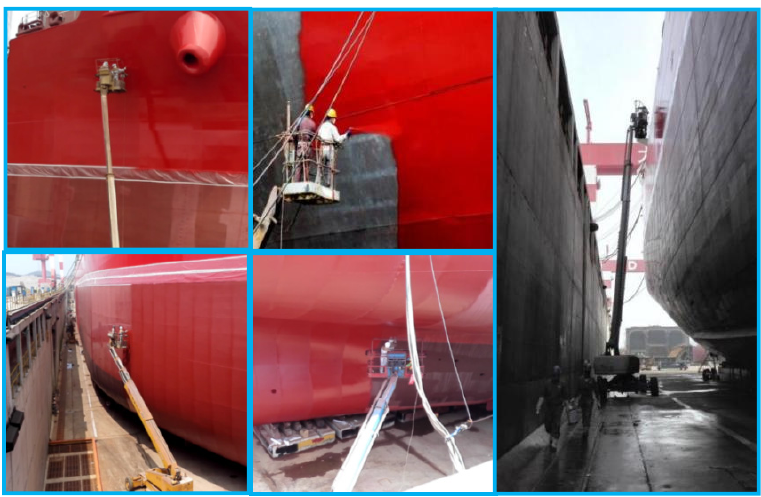
Figure 1. Current situation of coating on ship’s outer plate in shipyard.